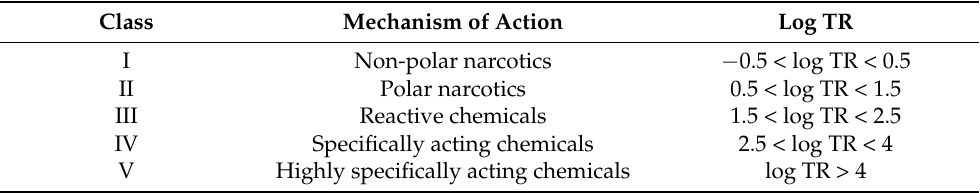
Table 1. Classification scheme of pesticides based on mechanisms of action [18].